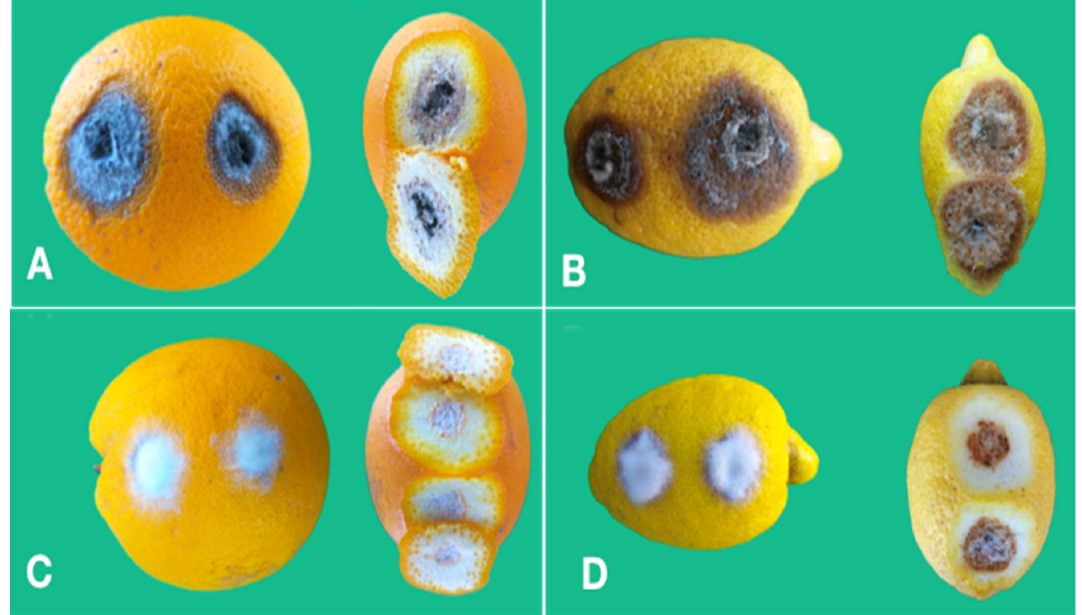
Figure 8. ( A ) Necrotic lesions around the inoculation point in a fruit of sweet orange “Tarocco Meli” wound inoculated with an isolate of Colletotrichum gloeosporioides 12 d.p.i.; the peel has been removed to show that the necrosis extends into the albedo. ( B ) Necrotic lesions around the inoculation point in a fruit of lemon “Femminello 2Kr” wound inoculated with an isolate of Colletotrichum gloeosporioides 12 d.p.i.; the peel has been removed to show that the necrosis extends into the albedo. ( C ) Aerial mycelium developed on the two inoculation points in a fruit of sweet orange “Tarocco Meli” wound